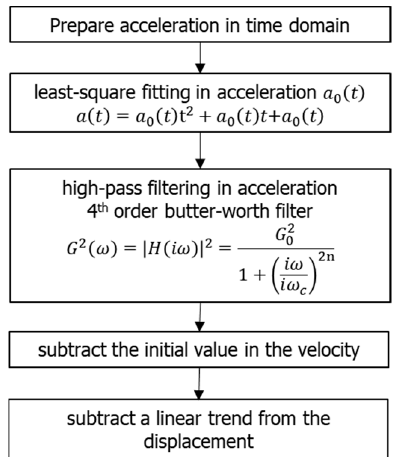
Figure 7. Flowchart for conversion of acceleration data in Method 3.